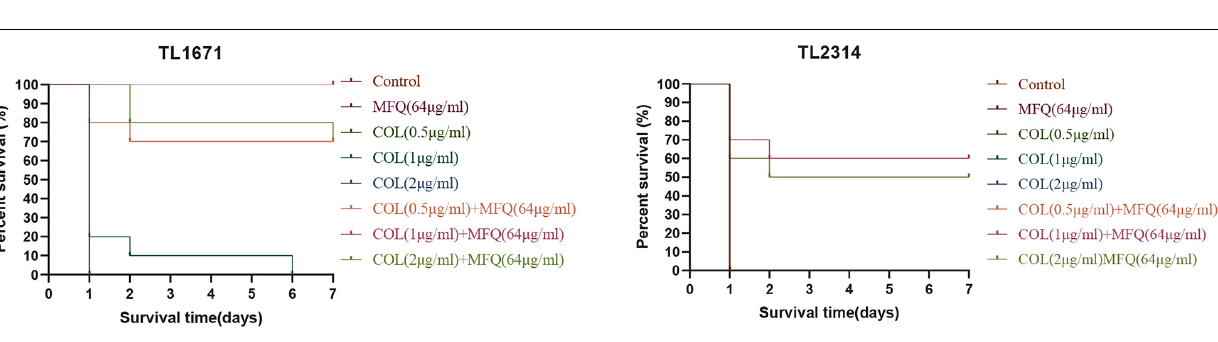
FIGURE 5 | Survival rate of G. mellonella . We selected TL1671 and TL2314 as the experimental strains, and recorded the survival rate of G. mellonella in 7 days. Mefloquine (MFQ) and colistin